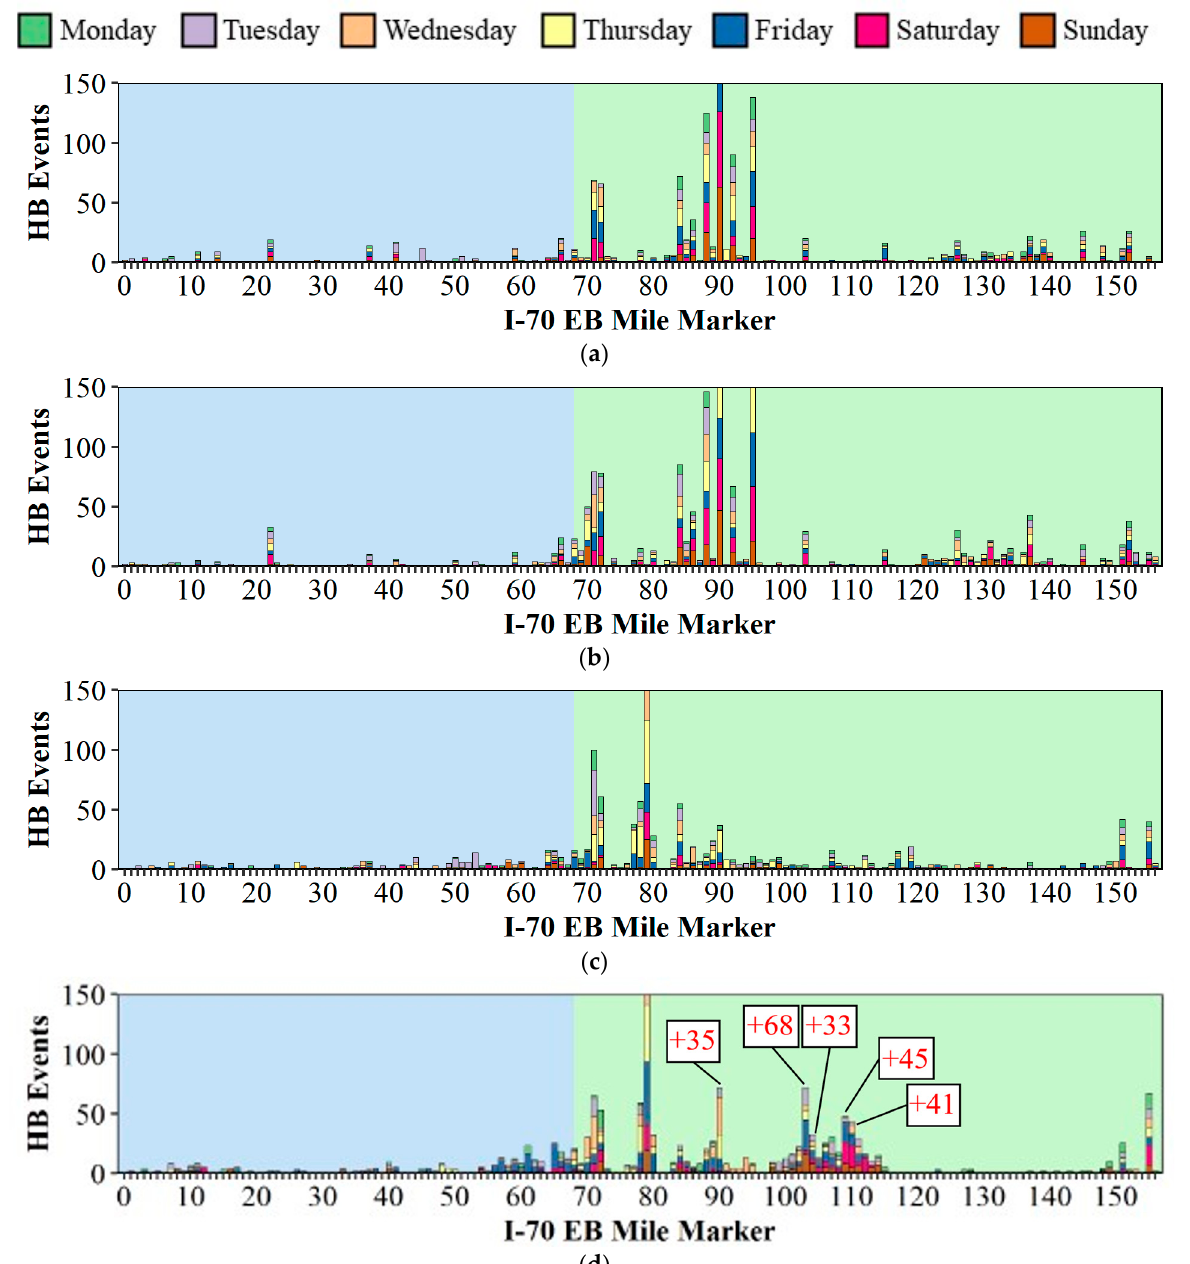
Figure 11. Hard-braking events for each 1-mile segment on I-70 EB. ( a ) Sunday, 24 May—Satur-